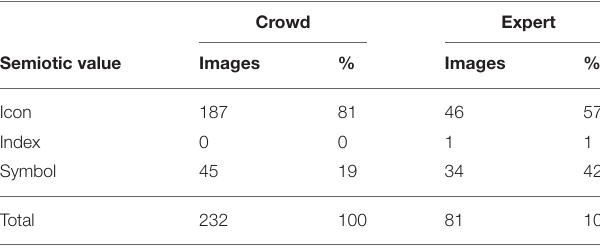
TABLE 4 | Semiotic distribution of introduced images [Sg to Sd (1)